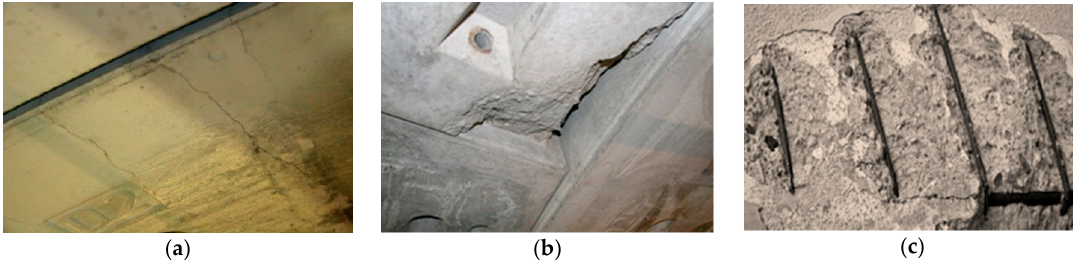
Figure 1. Mechanical defects in tunnels: ( a ) fissures; ( b ) detachments on precasts; ( c ) seen steel frames.